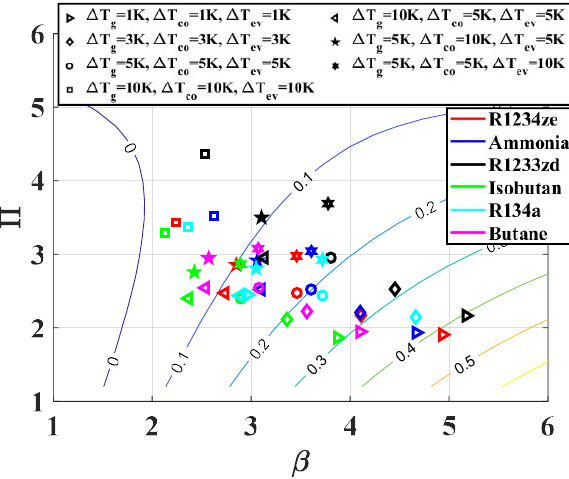
Figure 4. Entrainment ratio (contour plot) as a function of beta ratio and pressure lift for different pinch point values at the heat exchangers.